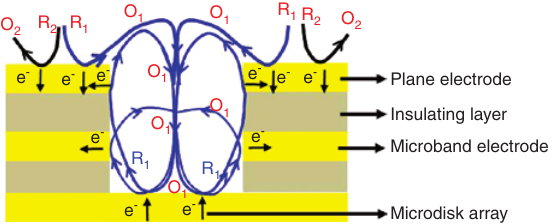
Figure 6: A schematic diagram of the working principle for detec- tion based on the strategy of interferent depleting and redox cycling using plane-recessed MEA systems. R is the intefering species.